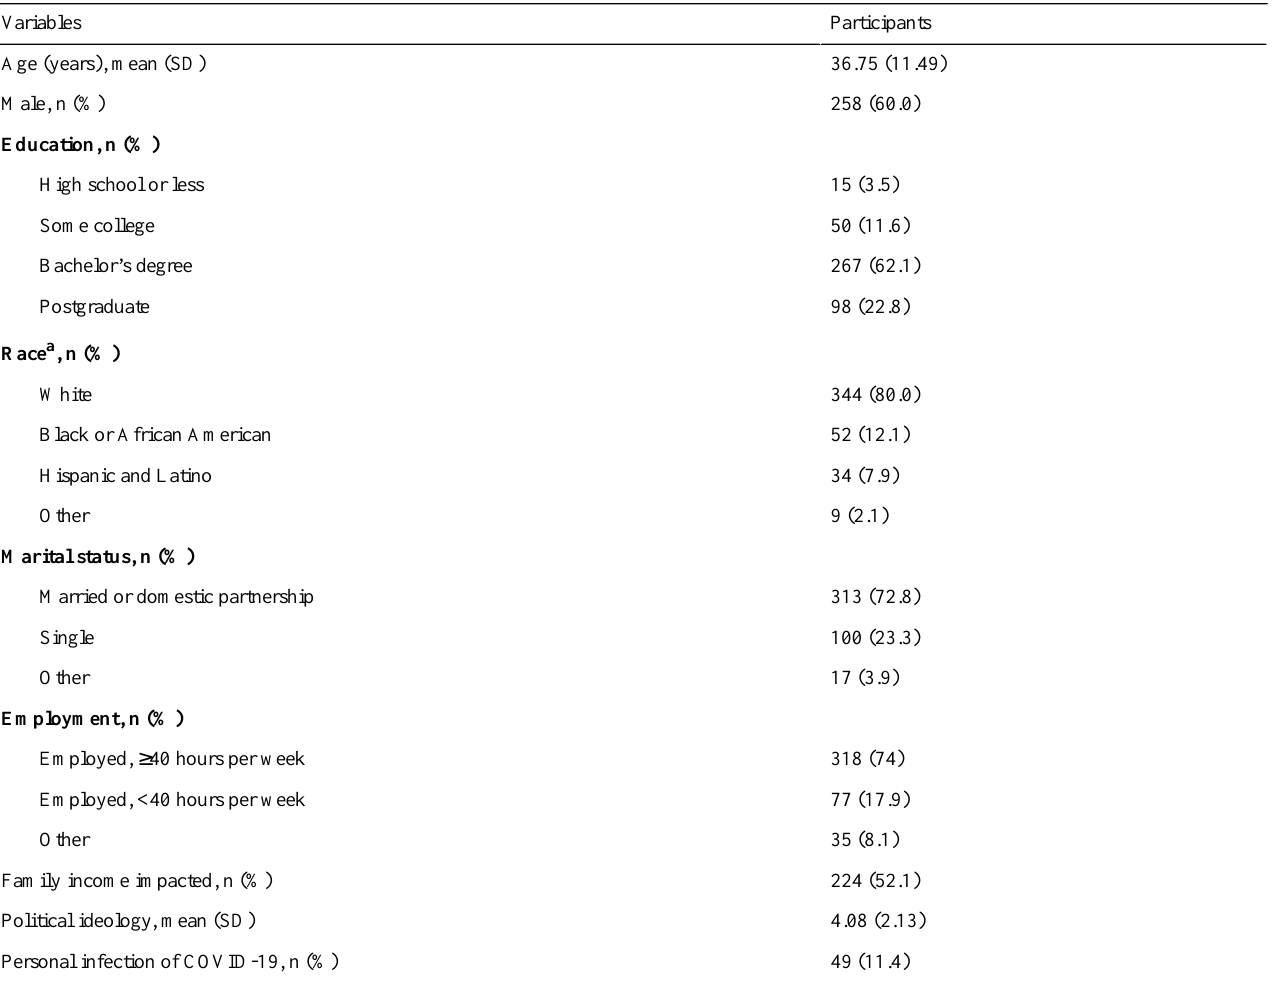
Table 1. Demographics of survey participants